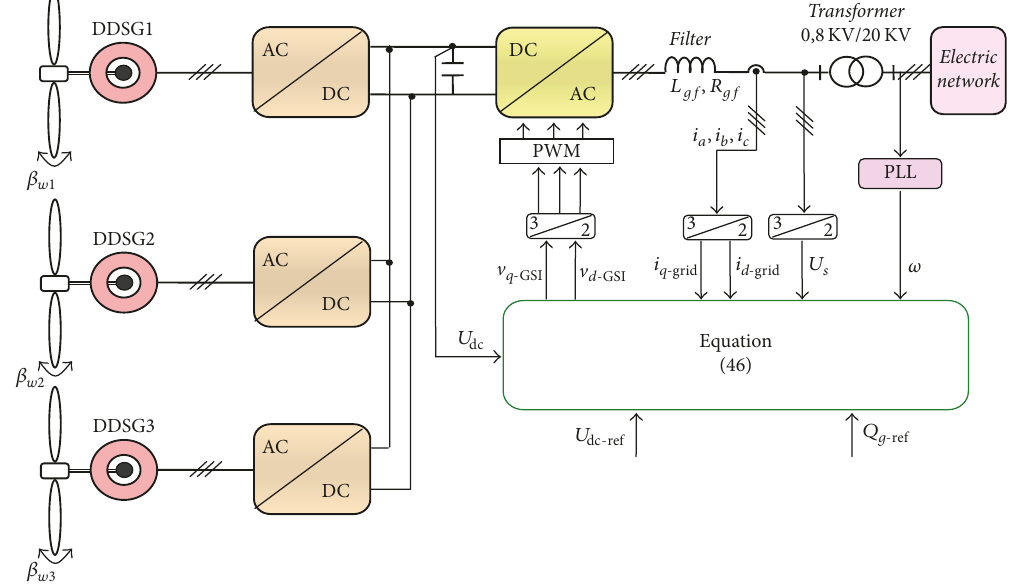
Figure 7: Control block diagram of